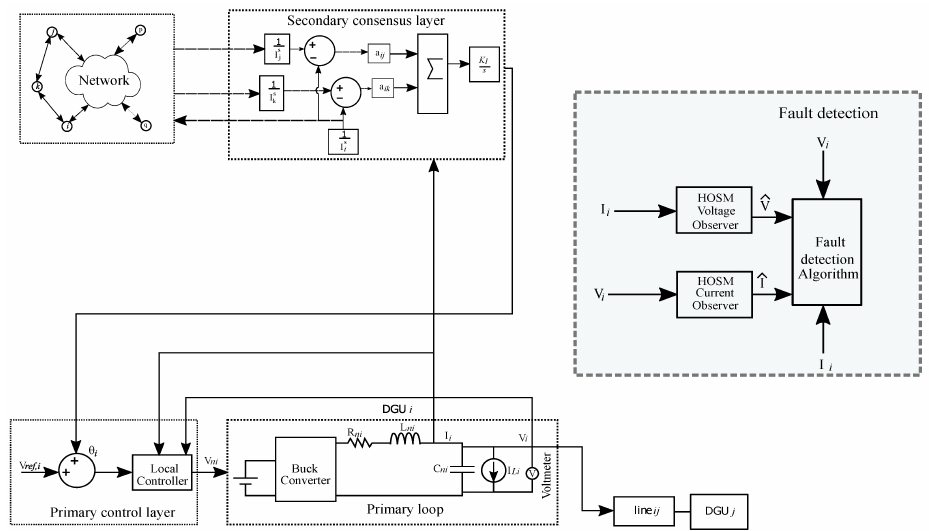
Figure 5. Functional block diagram of the i th distributed generation units with controllers and higher order sliding mode observers